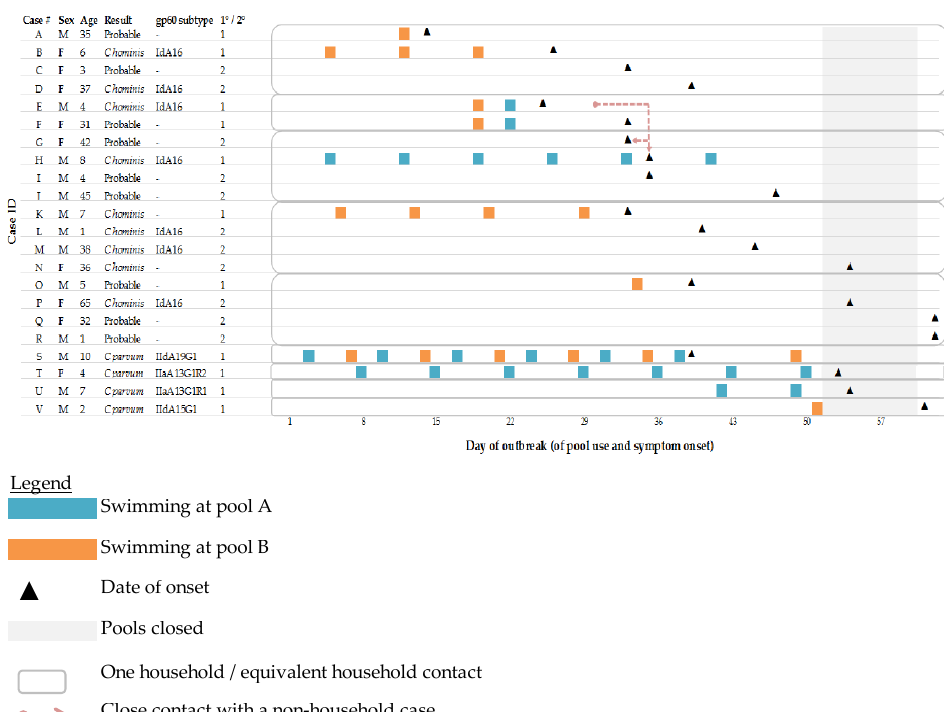
Figure 1. Distribution of outbreak-associated Cryptosporidium cases (and gp60 subtype) by week of onset of symptoms, North East England, 2016 (n = 22).